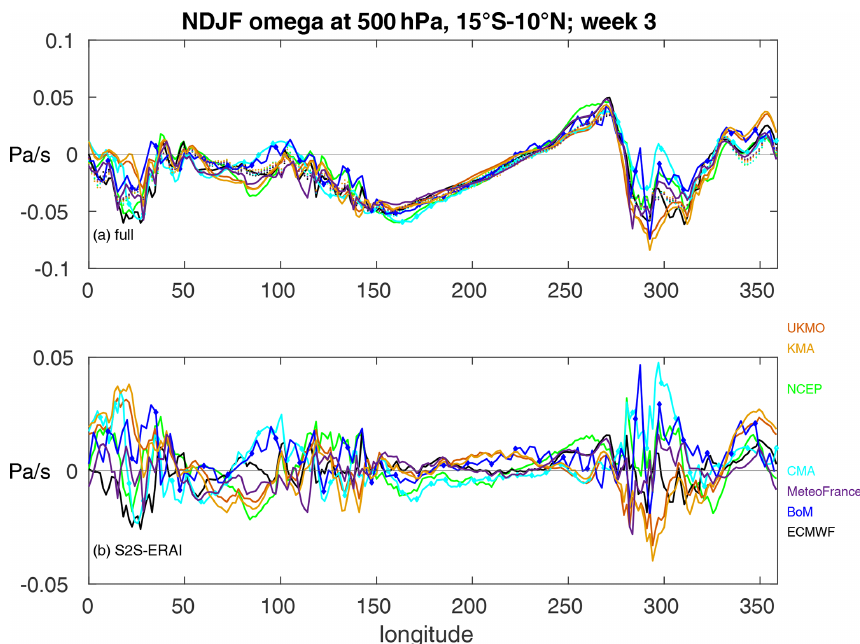
Figure 8. Longitudinal cross-section of NDJF 500hPa pressure–velocity ( ω ) averaged between 15 ◦ S–10 ◦ N during week 3 of integration for (a) S2S models (solid lines) and corresponding days in ERA-I (dots) and (b) the difference between S2S models and the corresponding days in